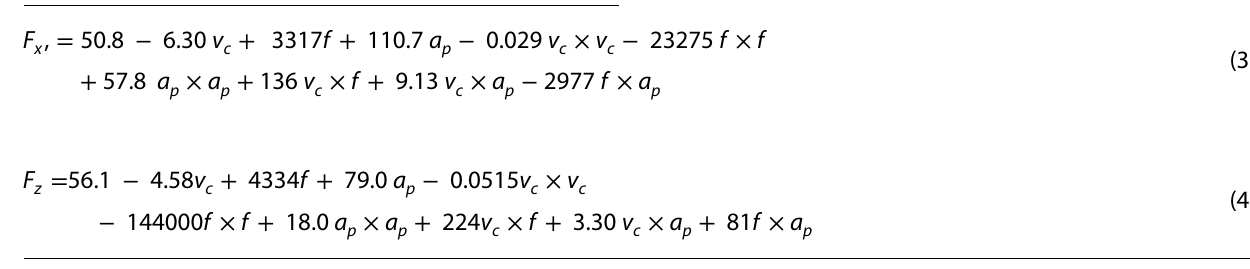
Table 4 ANOVA for analyzing F z , versus v